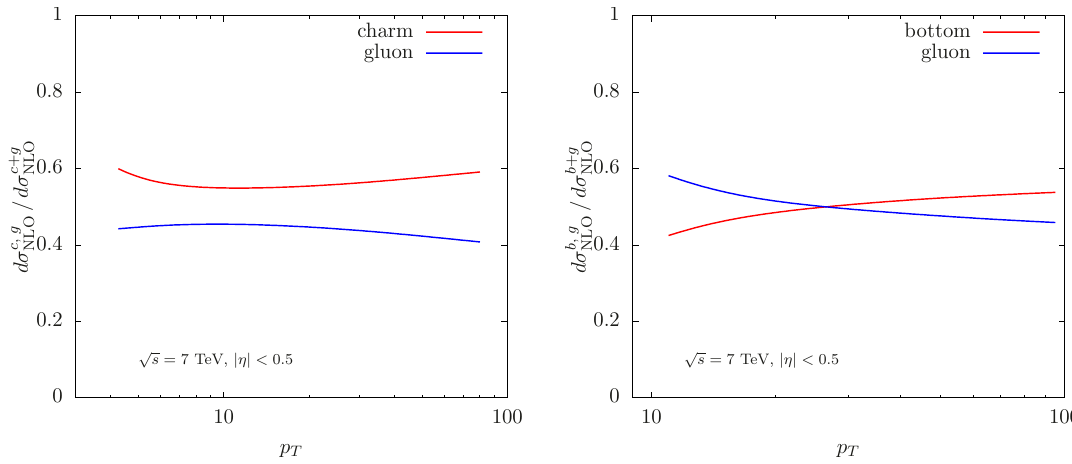
Figure 8 . The percentage contribution of the heavy quark and gluon fragmentation processes p to inclusive D -meson (left) and B -meson (right) production at NLO for s = 7 TeV. The heavy quark contribution (charm, bottom) is shown in red and the gluon is shown in blue. We use the fragmentation functions of [55, 82{84] (left) and [56, 93, 94] (right) within the ZM-VFNS and we q have as usual (cid:22) R;F = m T = p 2 + m 2 T c;b